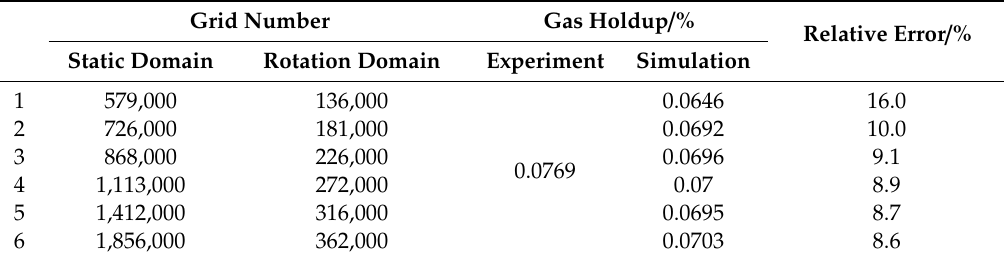
Table 4. The result of grid independence.